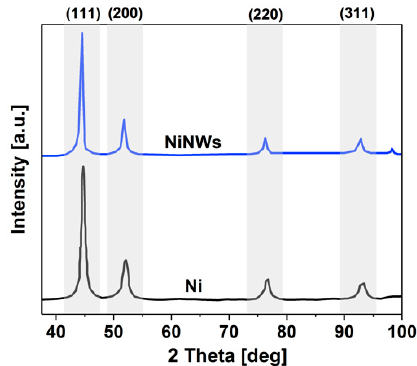
Figure 4. XRD patterns of NiNWs and Ni reference.